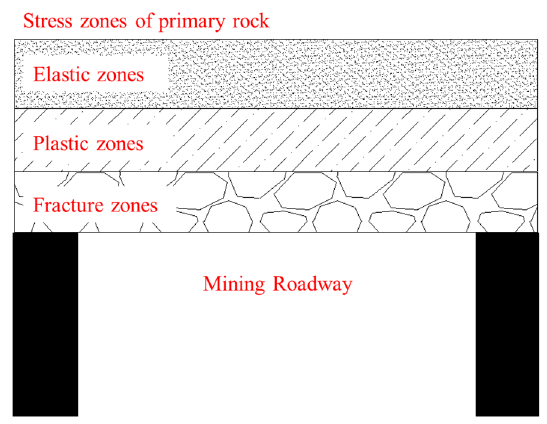
Figure 6. Distribution of roadway surrounding rock state.